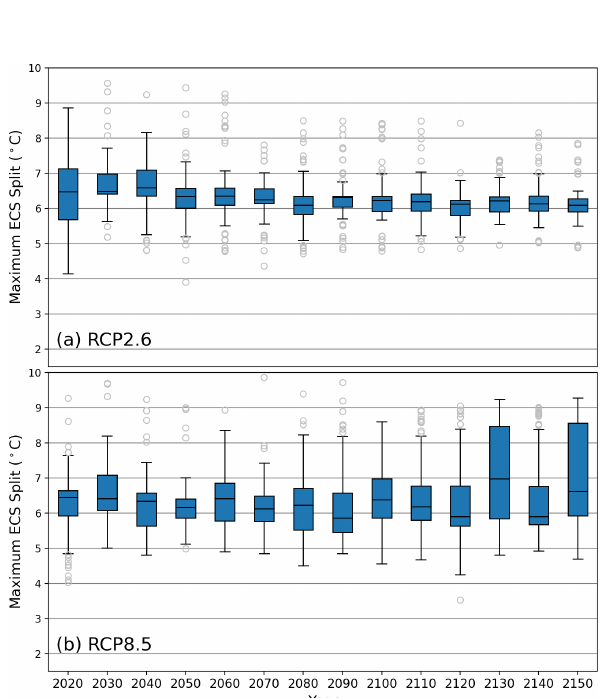
Figure A5. Distributions of the maximum equilibrium climate sensitivity (ECS) split value from each decision tree in the ran- dom forests fitted using the 80th percentile to classify the GMSL data. Panel (a) depicts the maximum ECS split distributions in the RCP2.6 forests, and panel (b) depicts the maximum ECS split dis- tributions in the RCP8.5 forests. The outliers are the data points less than Q1 − 1 . 5 · IQR or greater than Q3 + 1 . 5 · IQR, where Q1 is quar- tile 1, Q3 is quartile 3, and IQR is the interquartile range (Q3–Q1). The blue boxes show the IQR, and the line within the IQR is the